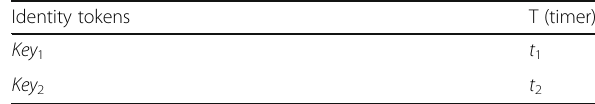
Table 5 List of identity tokens Identity